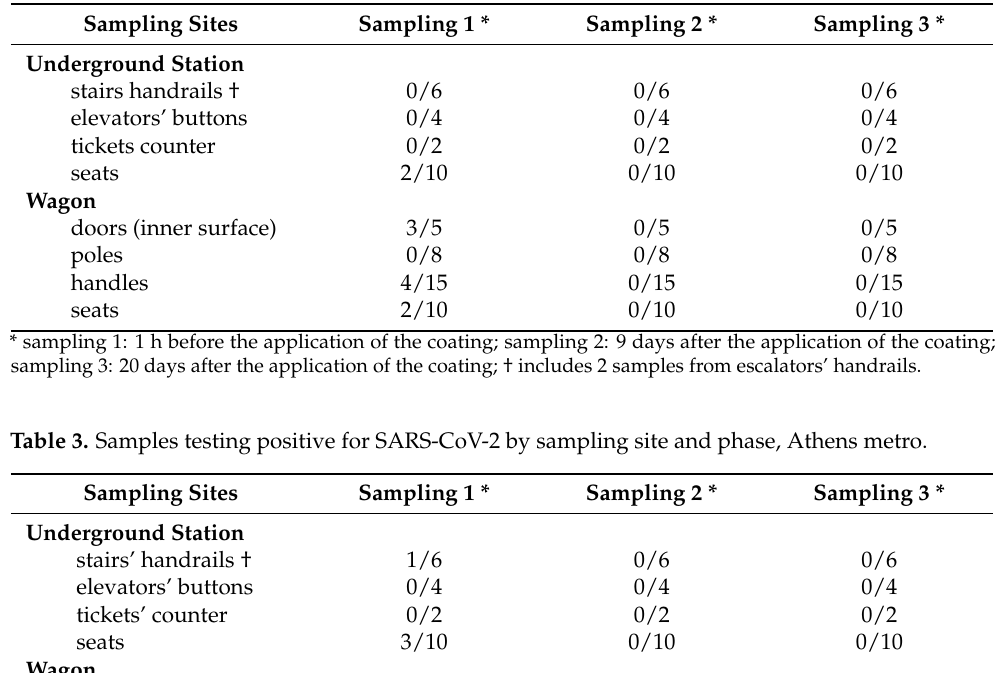
Table 2. Samples testing positive for fungi by sampling site and phase, Athens metro.